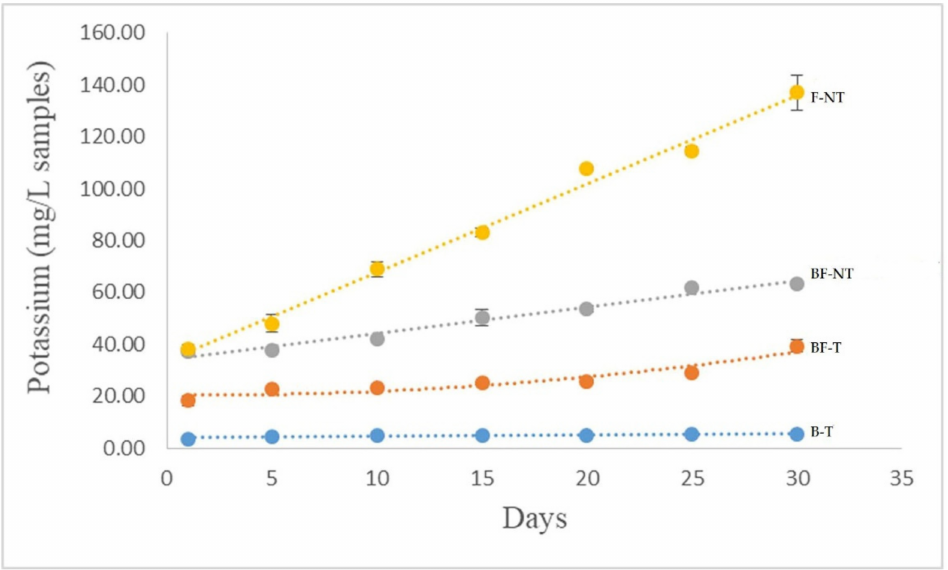
Figure 8. Potassium release at five day intervals for 30 days of a water incubation experiment.